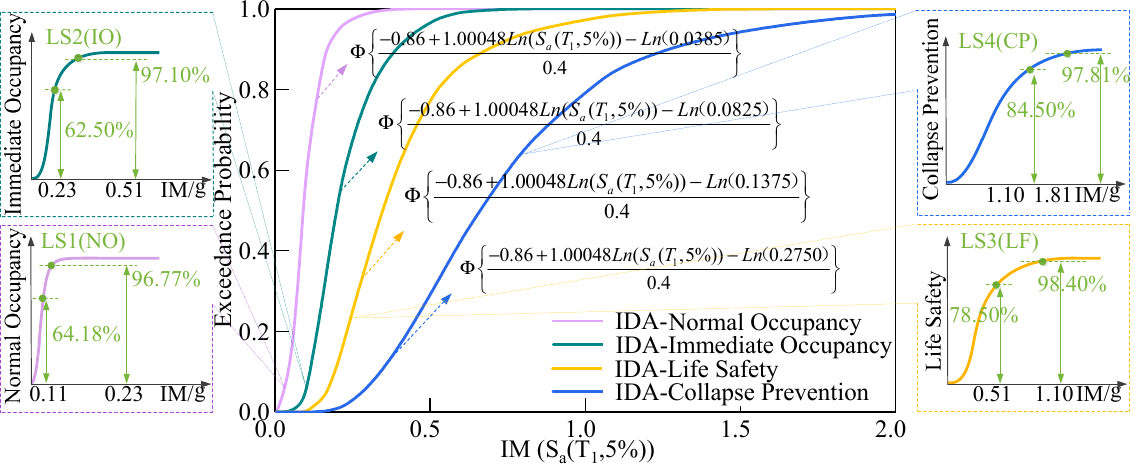
Figure 11. Fragility curves (IDA).